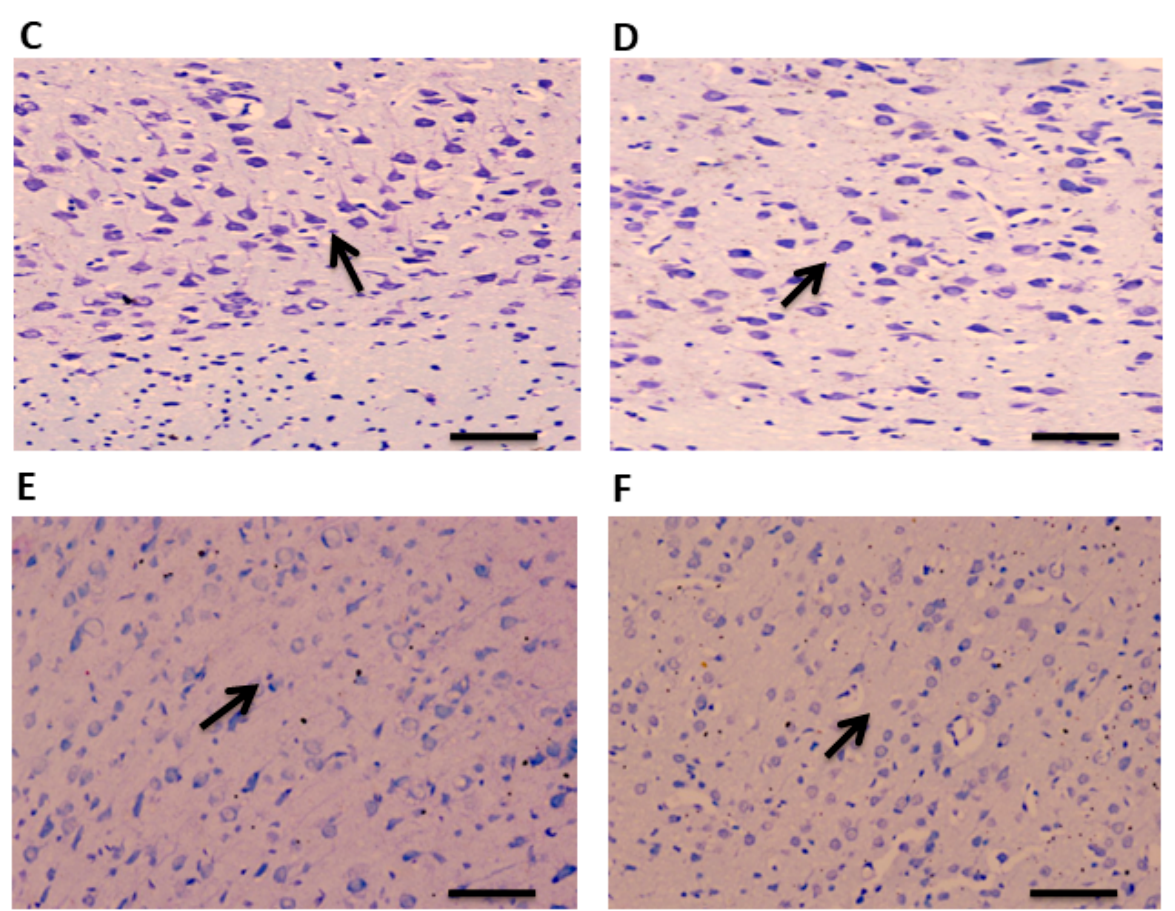
Figure 2. CV staining showing cellular organization in the hippocampus, ATL, and neocortex of TLE rats. Arrows indicates morphological changes and disrupted organization of layers in the hippocampal samples of TLE rats compared to control rats ( A , B ). Arrows show altered morphological changes and neuronal organization in the ATL samples of TLE rats compared to control rats ( C , D ). No significant changes in the morphology and neuronal organization were observed in the neocortical samples of TLE rats compared to control rats ( E , F ). Scale bars: 20 μ m.